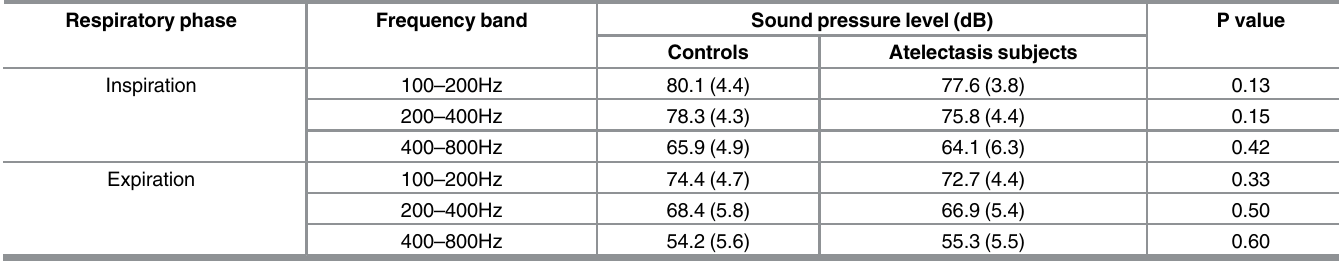
Table 2. Baseline breath sound sound pressure levels over the right middle lobe in the control and atelectasis subjects.